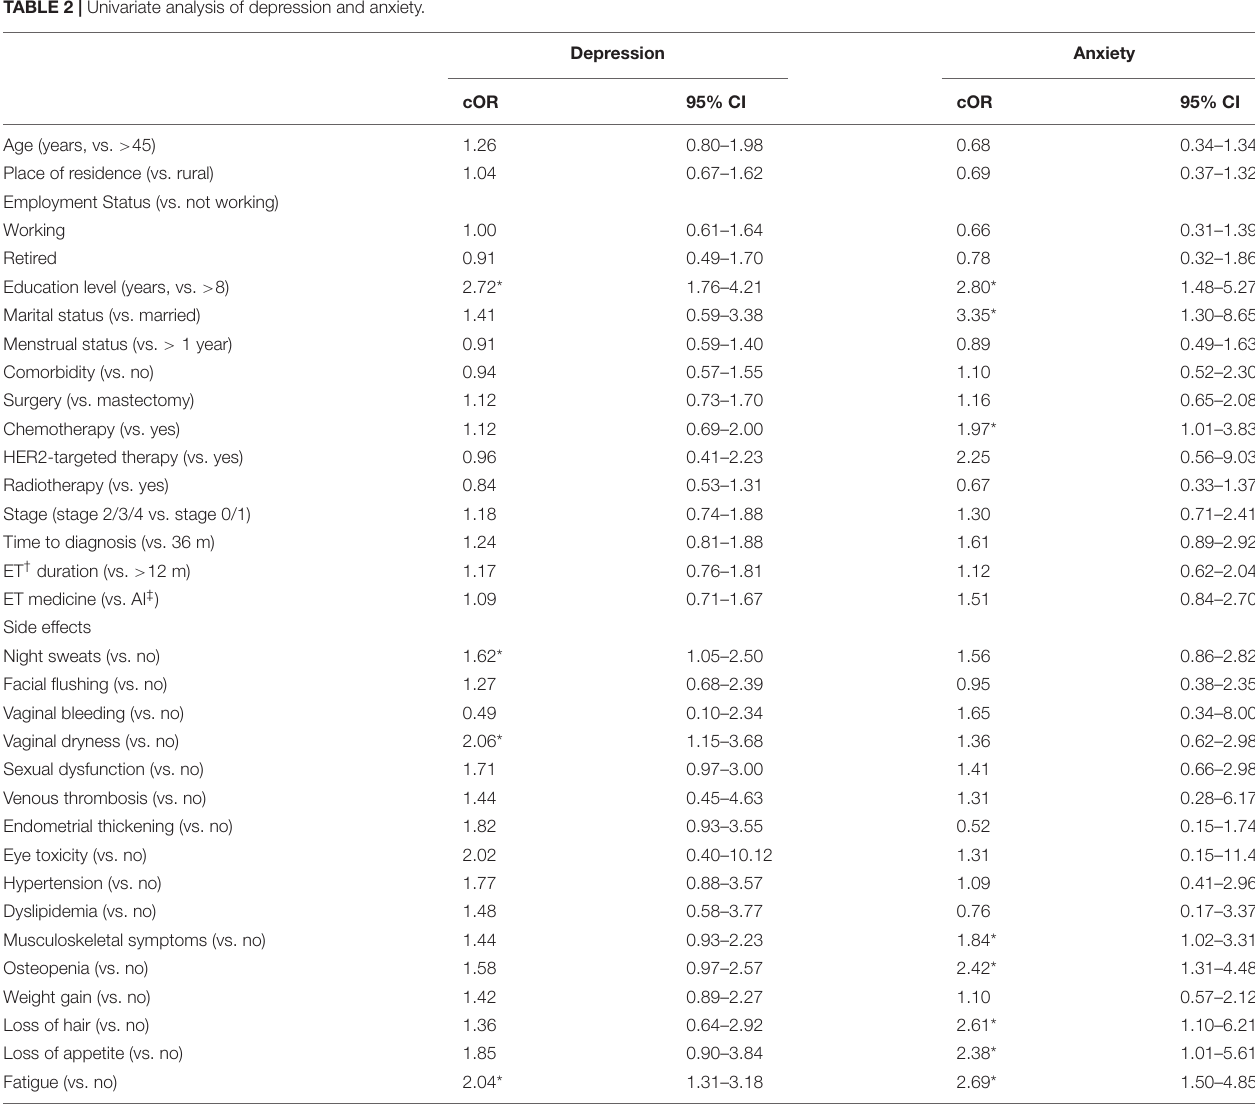
TABLE 2 | Univariate analysis of depression and